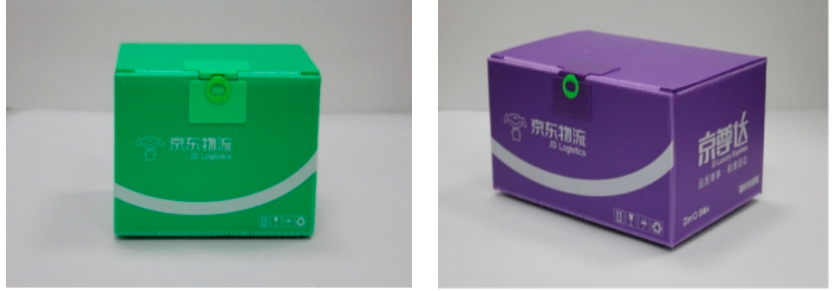
Figure 11. Image of a “Qingliu” box from JD.com.